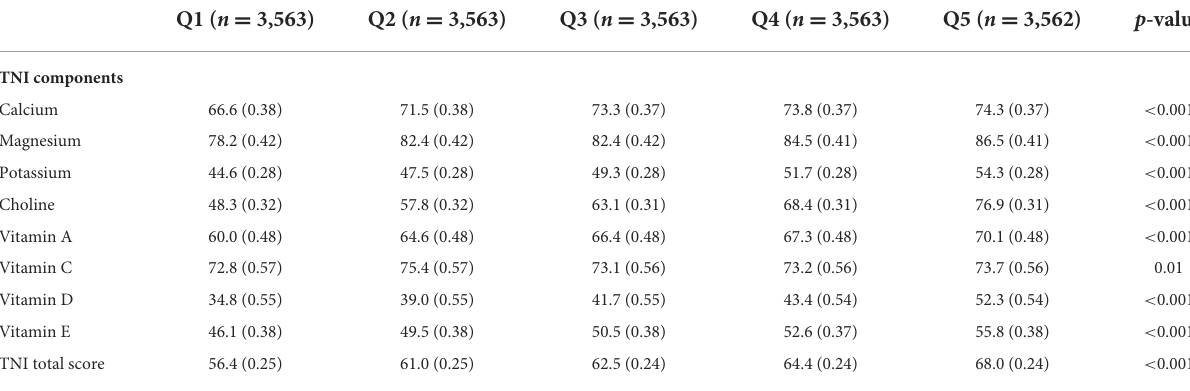
TABLE 3 Differences in Total Nutrient Index scores across %E P:C z -score quintiles.